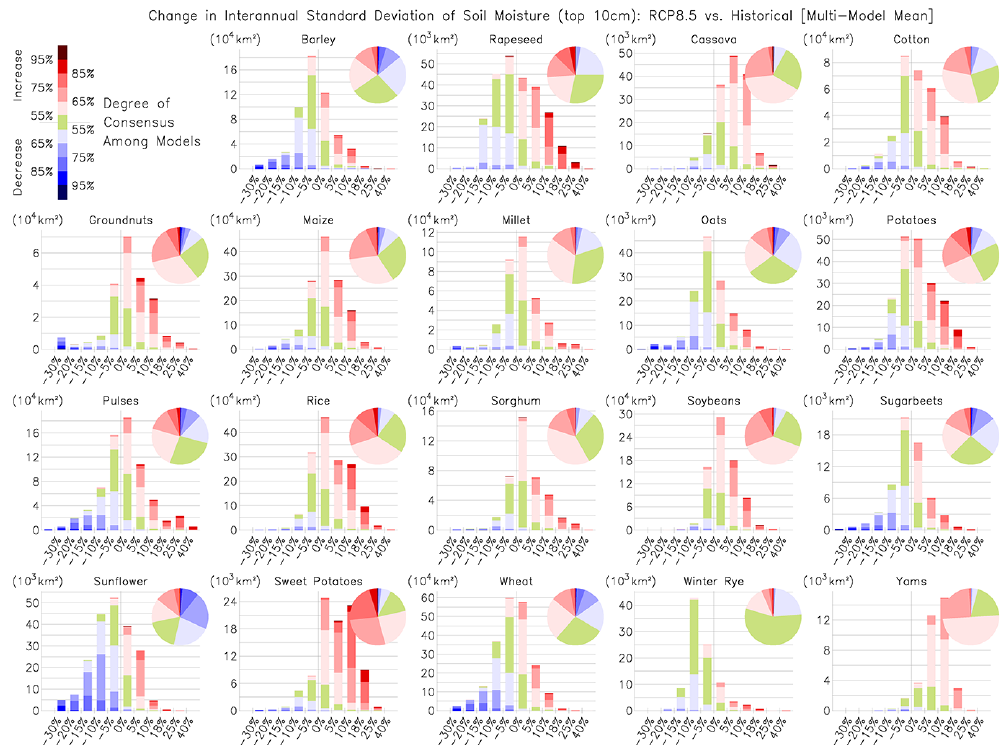
Figure 9. As in Fig. 7 but for changes in IASD from the historical case to the RCP8.5 case.